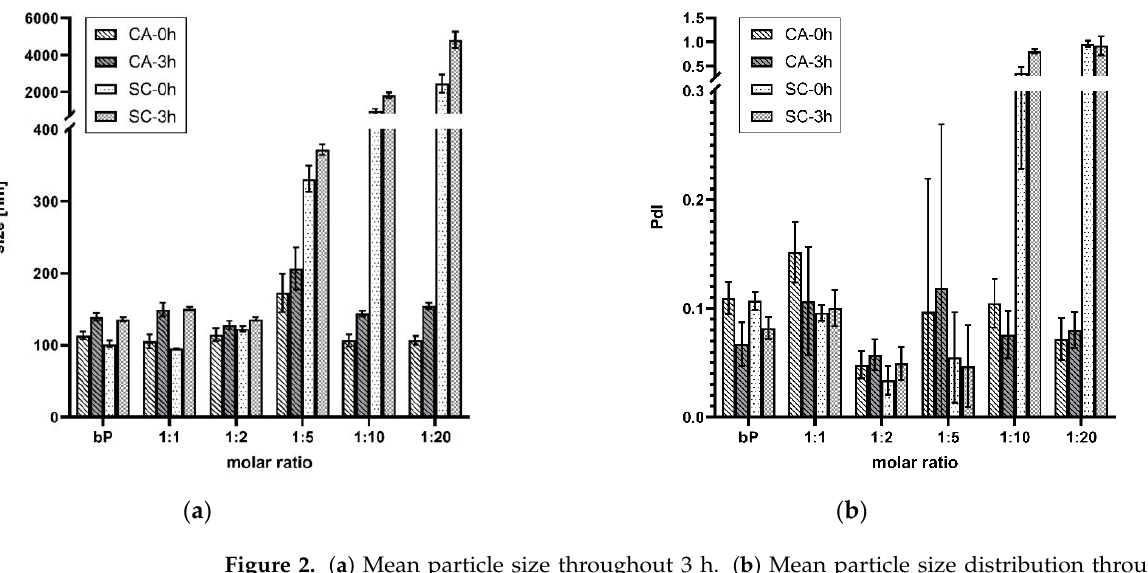
Figure 2. ( a ) Mean particle size throughout 3 h. ( b ) Mean particle size distribution throughout the 3 h. Comparison of proticles supplemented with citric acid (CA) and sodium citrate (SC). The measuring points at 0 h represent 15 min and 3 h after preparation, and the results are given as mean values ( n = 3) ± standard deviation. The molar ratio refers to a molar protamine:CA ratio.